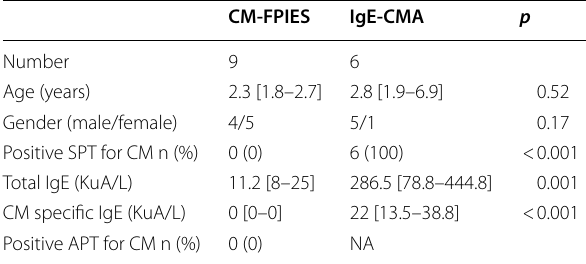
Table 1 Clinical characteristics of